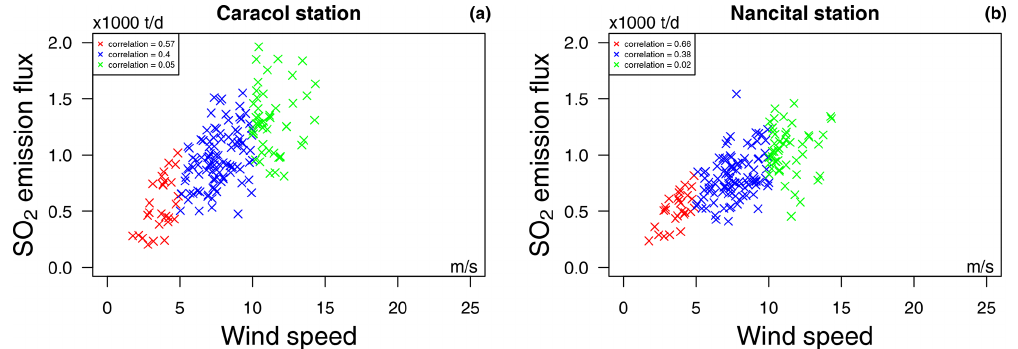
Figure D1. Correlation between the retrieved SO 2 emission fluxes and the wind speed for March to October 2014 and when the triangulation results are directly used. The plots compare daily SO 2 means and the means of the calibrated wind speed at the respective measurement times. The fluxes were calculated based on the triangulated plume height and plume propagation direction and based on the calibrated wind